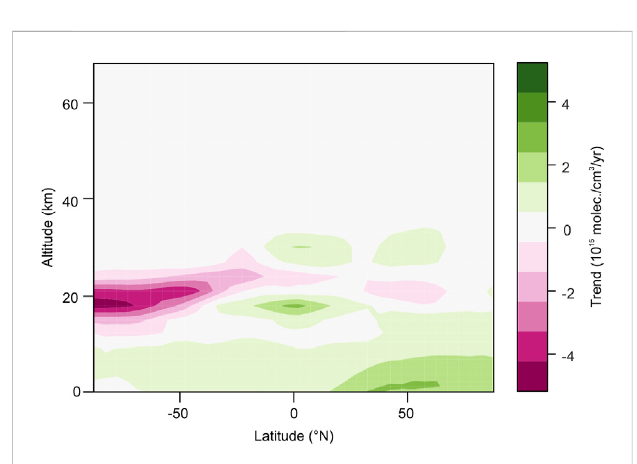
Trend on the ozone number density in annual mean ozone in the assimilated dataset (HISTOZv2) from 1924 to